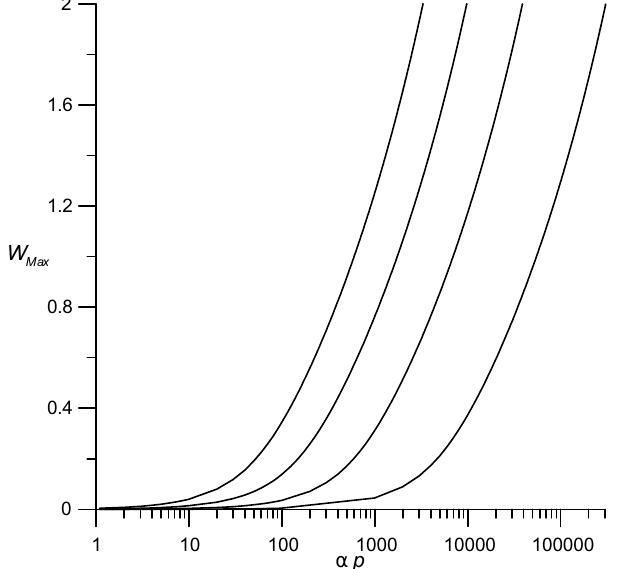
Fig. 10. Variation of the maximum nondimensional deflection W Max with the applied nondimensional load αp for sliding-clamped plates of inner radii b = 0 . 1 , 0 . 3 , 0 . 5 , and 0 . 7 .